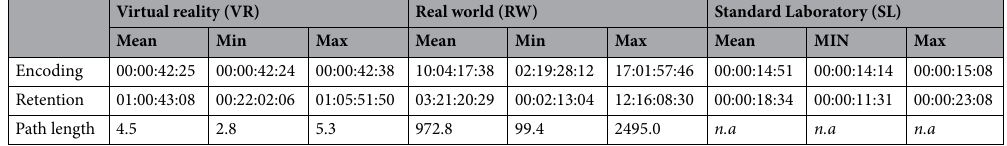
Table 1. Main spatio-temporal characteristics of the three encoding contexts. Encoding : time between the encoding of the first and the last object. Retention : time between the encoding of the last object and the retrieval of the first object (explicit source retrieval task). Times are in the format “DAYS:HOURS:MINUTES:SECONDS”. Path length : The participants’ total movement during the encoding phase. For the VR protocol the values correspond to “virtual” kilometers in the virtual town. For the RW protocol, the path length corresponds to kilometers in the real world. The SL protocol did not involve any real or virtual movement of the participant. VR virtual reality, RW real world, SL standard laboratory, n.a. not applicable.